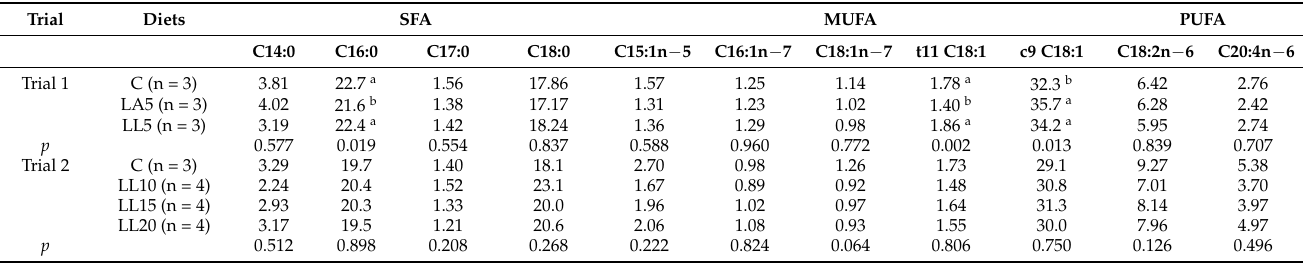
Table 5. Fatty acid (FA) composition (g/100 g identified FA) in LM of lambs affected by diets in trials 1 and 2.